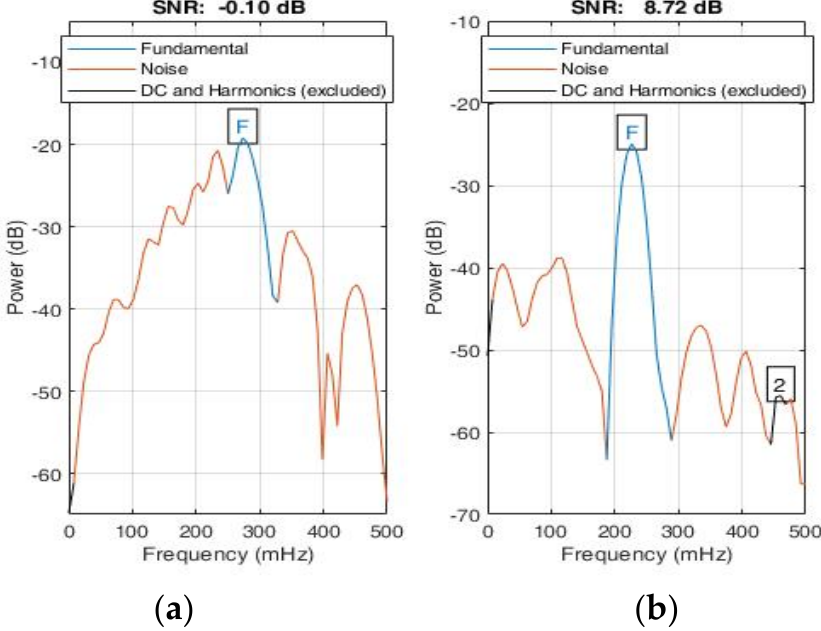
Figure 14. Signal-to-noise ratio ( a ) SNR of input signal, ( b ) SNR of reconstructed signal using symmetrical triangular QRS wave function.